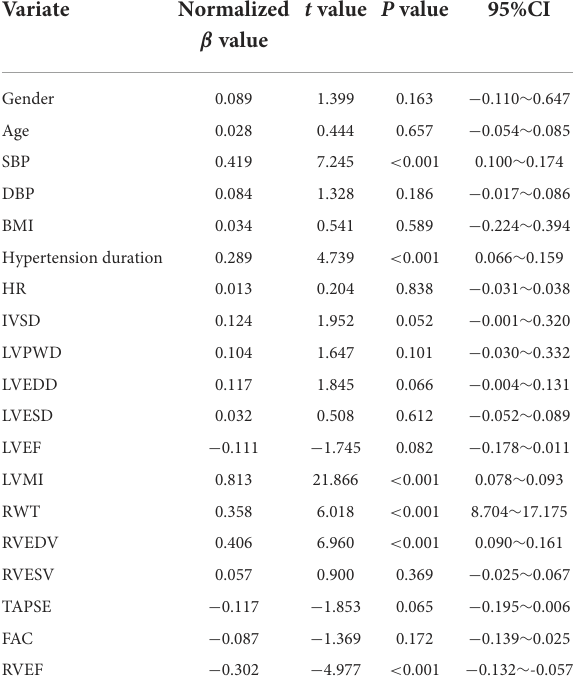
TABLE 4 Univariate regression analysis results of right ventricular free wall longitudinal strain. Variate